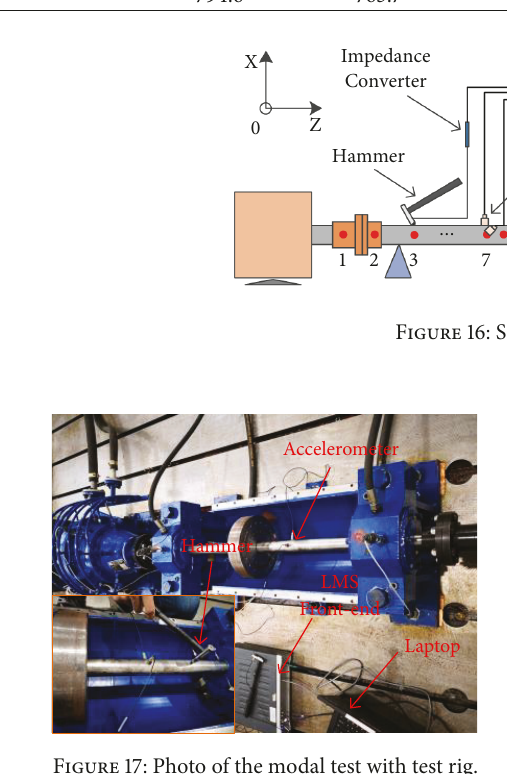
Figure 17: Photo of the modal test with test